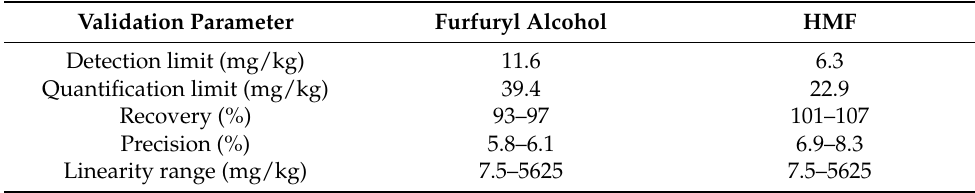
Table 1. Validation parameters for the quantitative determination of furfuryl alcohol and